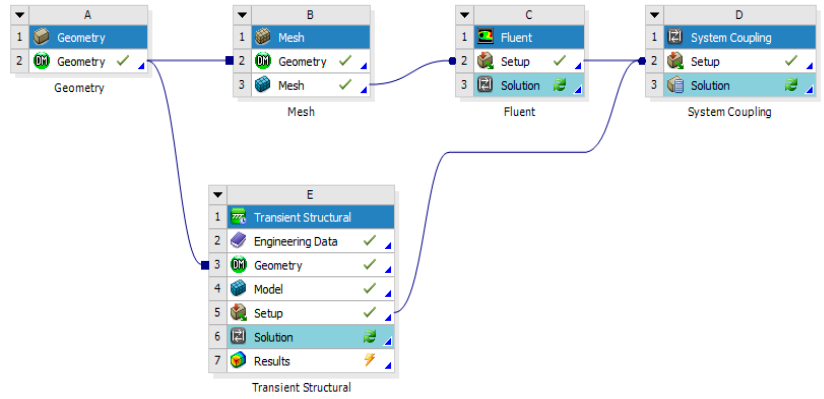
Figure 2. Two-way fluid ‒ solid coupling calculation setting diagram.